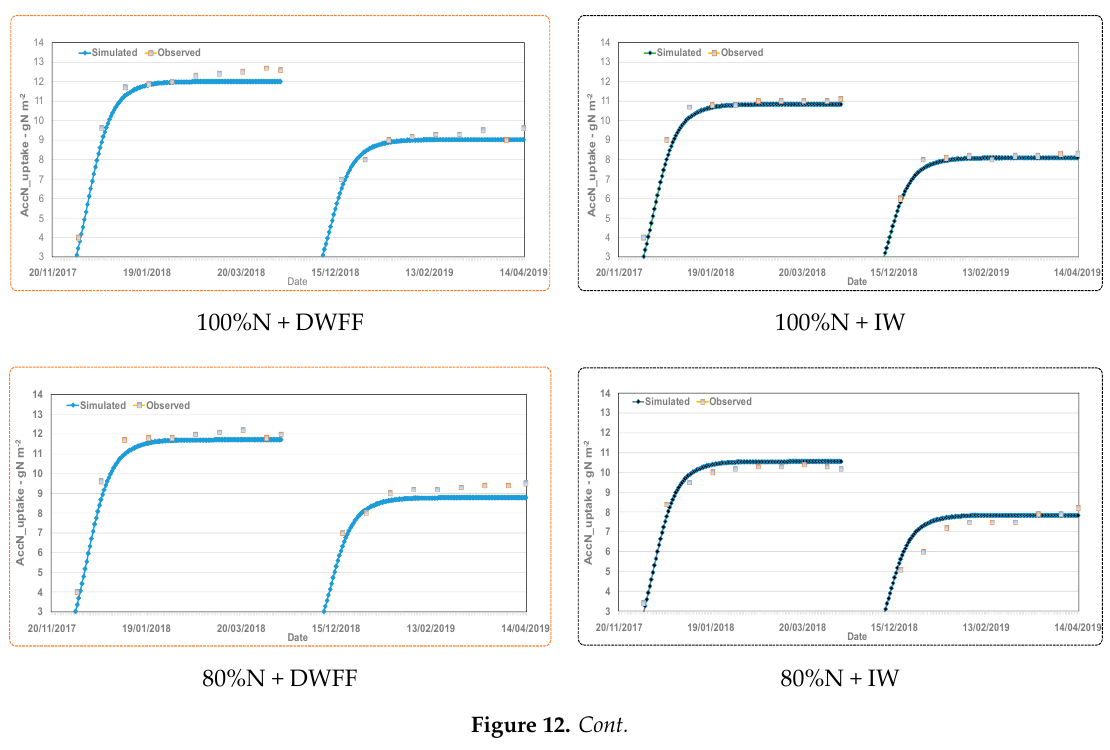
Simulated Observed 40%N + IW Figure 12. Observed and simulated accumulated-nitrogenuptake during 2017/2018 and 2018/2019 for all treatments: drainage water from fish farms(DWFF),fresh irrigation water (IW) and nitrogen (N).